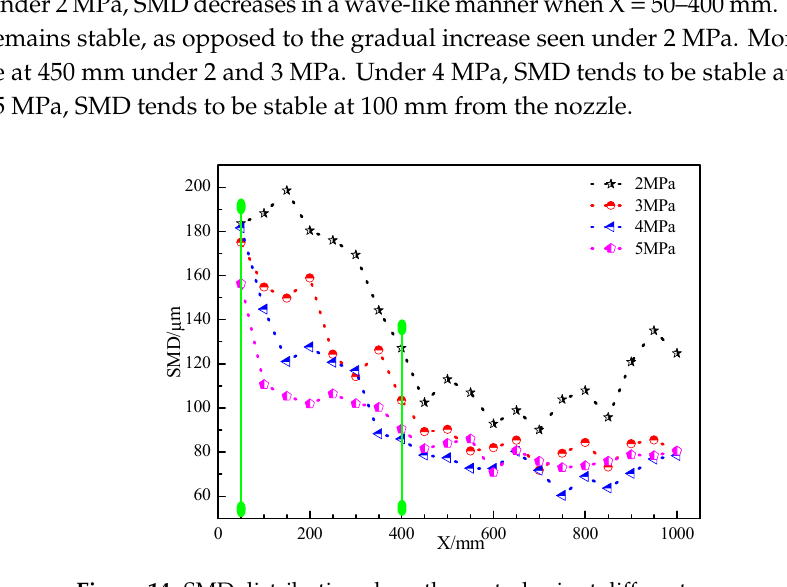
Figure 15. Axial and radial velocity along the axial direction under different pressures.